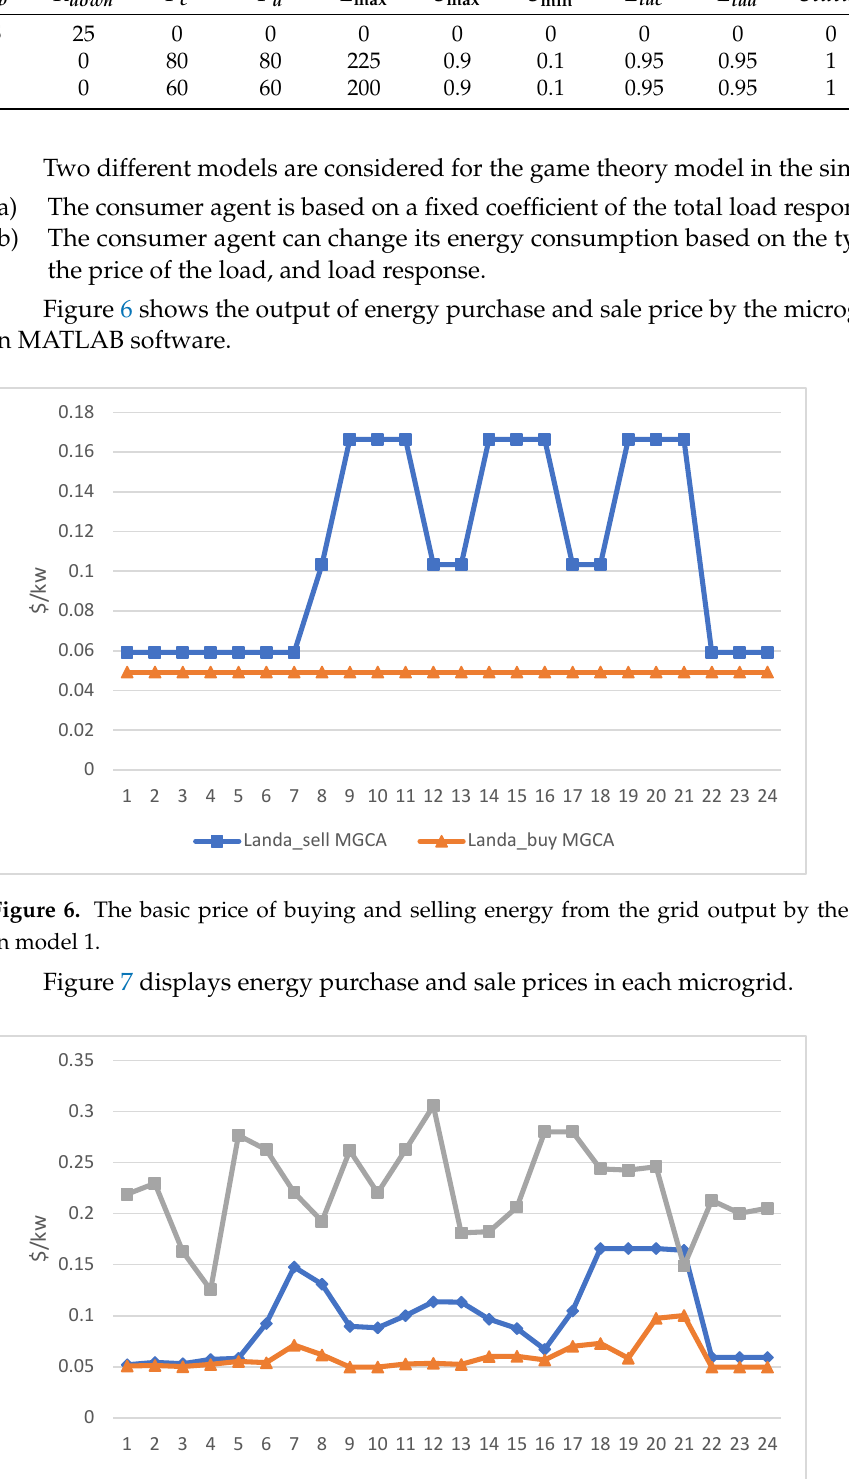
Figure 7. The basic price of buying and selling energy from each microgrid by